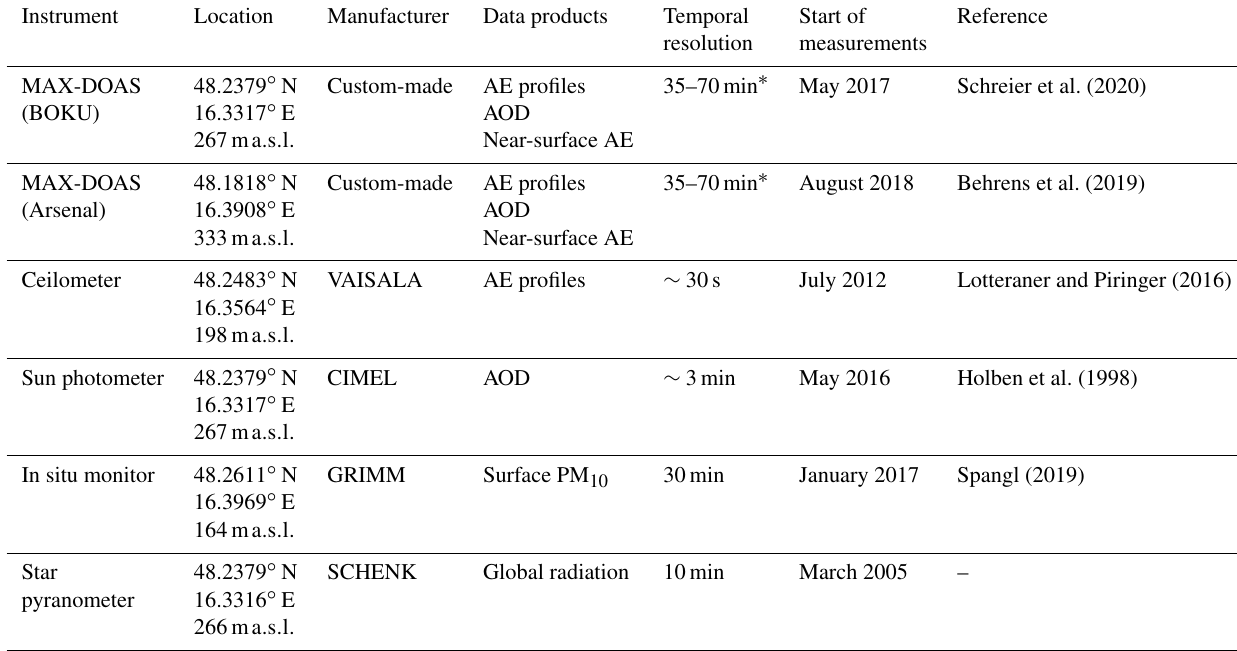
Table 1. Locations, data products, and characteristics of the instruments used in this study.